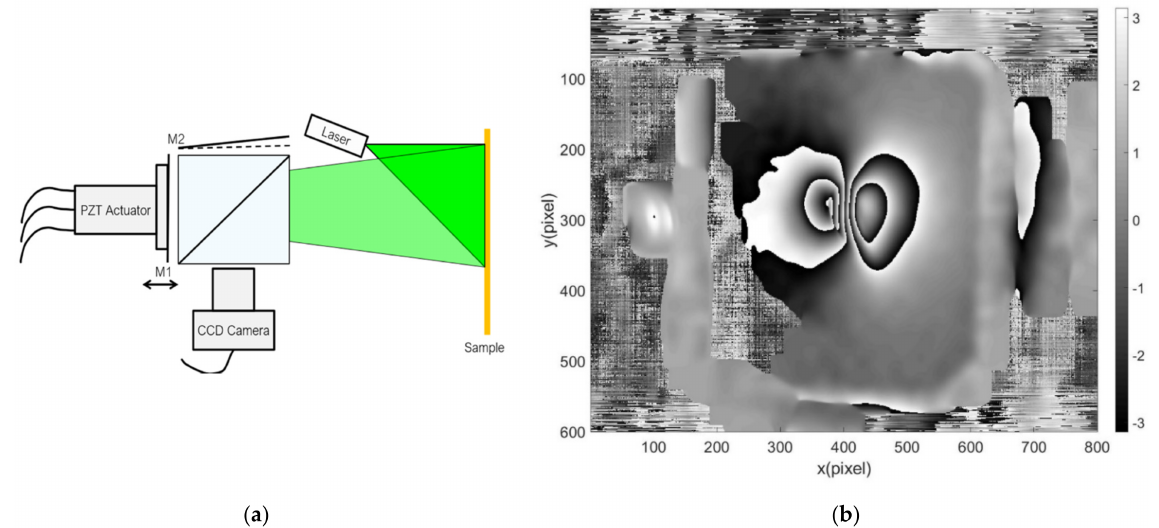
Figure 5. ( a ) Setup of conventional TPS-DS system with three-step phase shift; ( b ) Wrapped phase map retrieved by TPS-DS system.